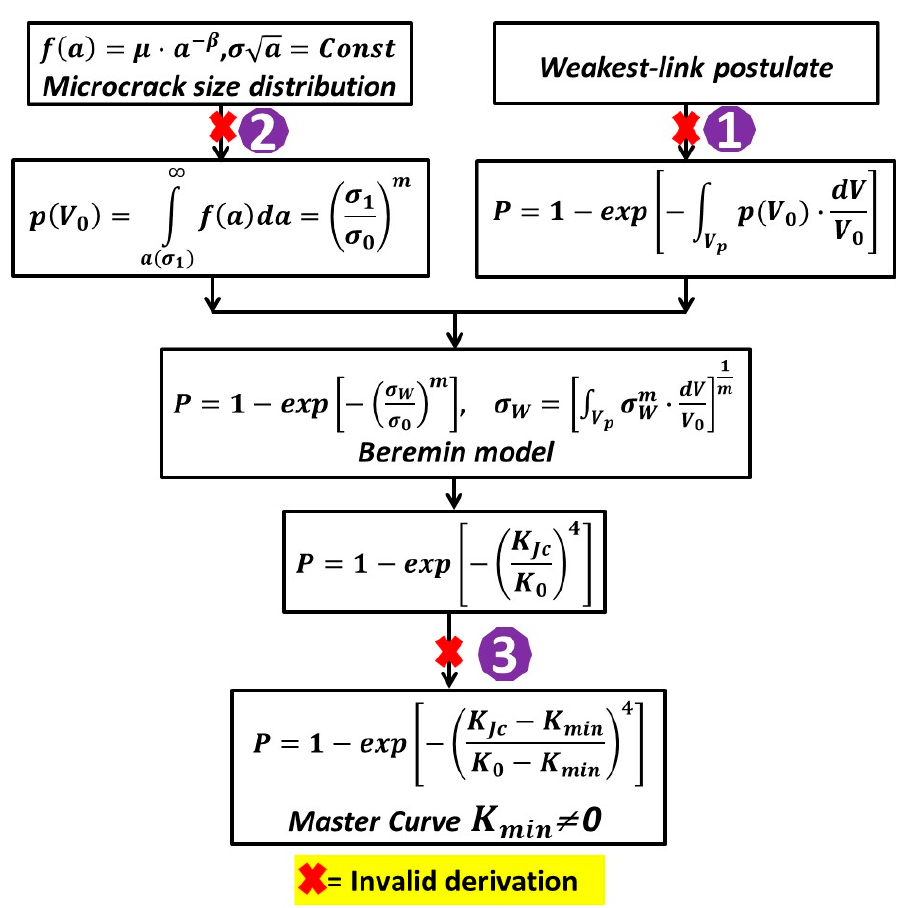
Figure 1. Formulation process of Beremin model and the non-transferrability of two- and three- parameter Weibull statistics of fracture toughness [9,21–24].